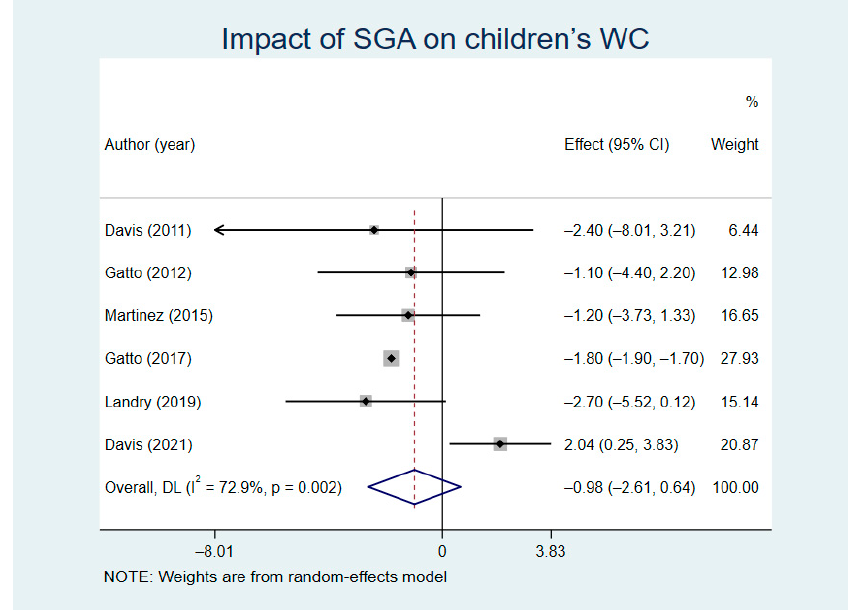
Figure 7. Impact of SGA on children’s waist circumference